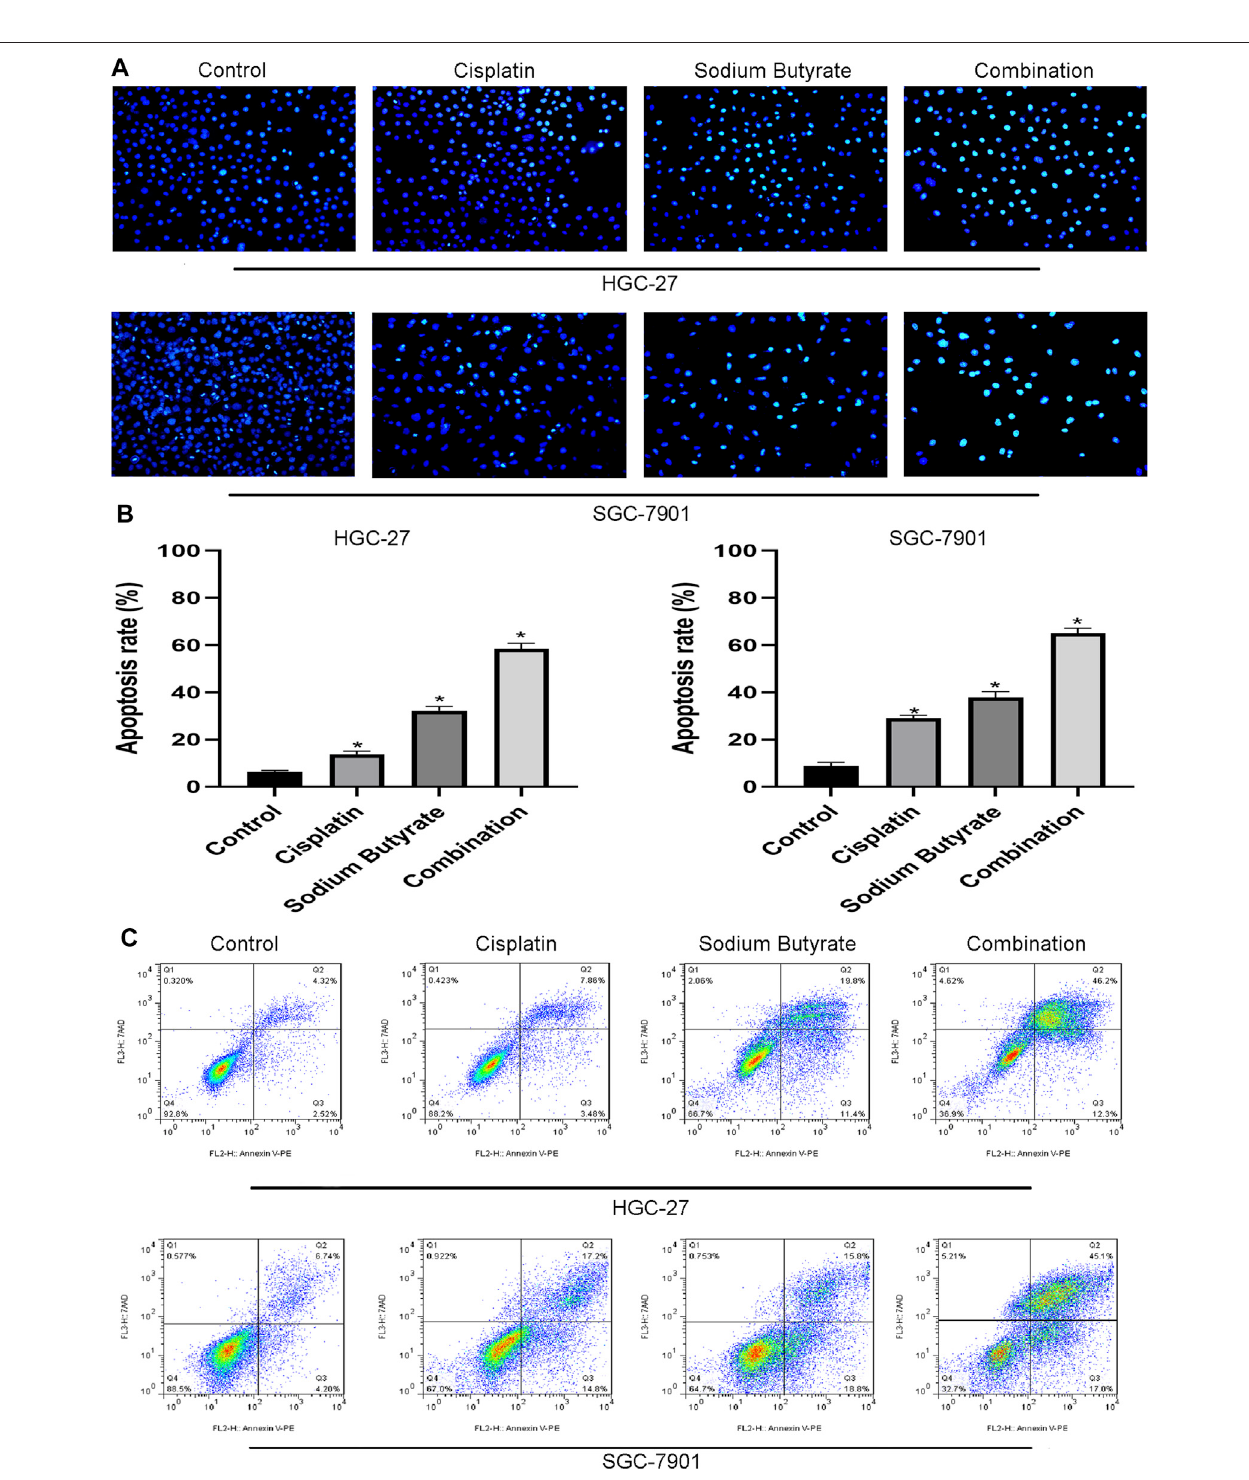
FIGURE 3 | Sodium butyrate combined with cisplatin promotes apoptosis of GC cells. (A) Original magni fi cation: × 200. HGC-27 cells were treated with control, 4 µg/ml cisplatin, 10 mM sodium butyrate, or 4 µg/ml cisplatin +10 mM sodium butyrate; SGC-7901 cells were treated with control, 4 µg/ml cisplatin, 5 mM sodium butyrate, or 4 µg/ml cisplatin +5 mM sodium butyrate. (B) Quantitative analysis of the apoptosis rate in each group. * p < 0.05 vs the control. (C) Quantitative fl ow cytometry measurements of apoptosis in GC cells. All the above data are the mean ± SD from an average of three experiments.